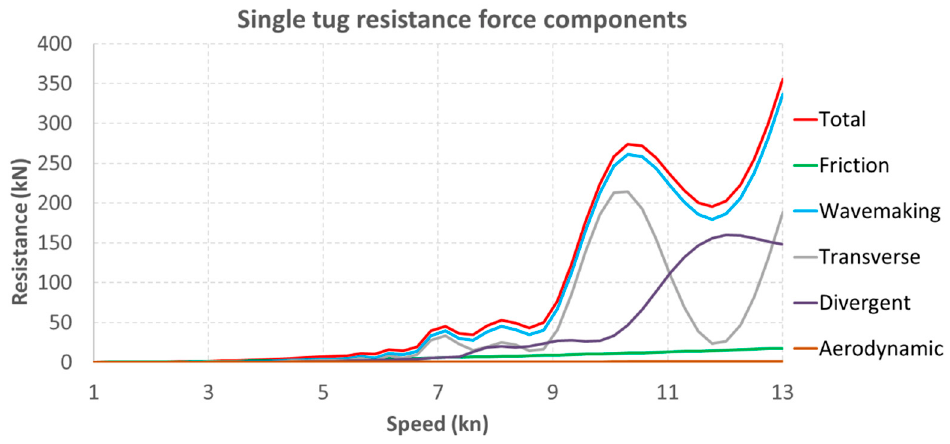
Figure 5. Resistance force components acting on a single tug used in a formation. Table 1. Percentage of components of the total drag force FTR acting on a single tugboat at differ- ent speeds.